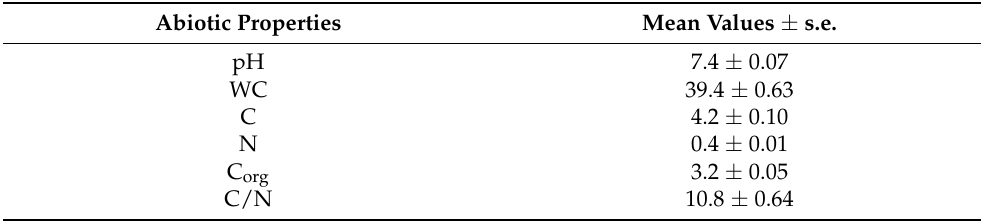
Table 1. Mean values ± s.e. (n = 14) of soil properties (pH; water content: WC (% d.w.); C total concentration (% d.w.); N total concentration (% d.w.); organic carbon concentration: C org (% d.w.); C/N ratio (% d.w.)) at the beginning of the experiment